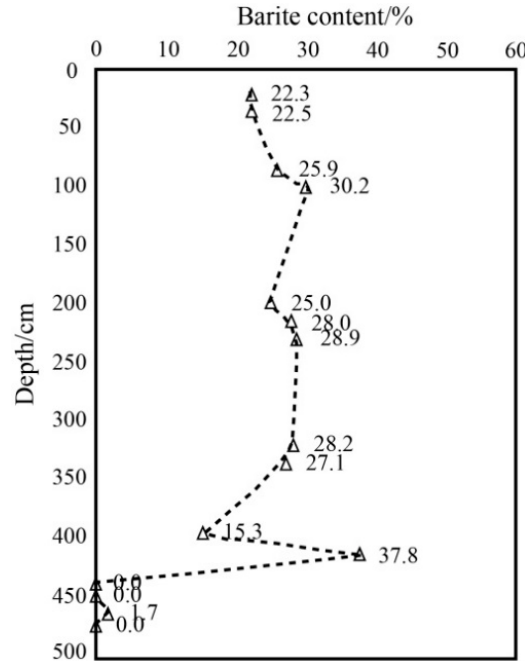
Figure 1. Vertical distribution of barite content at the T1 station of Qiongdongnan Basin [28].